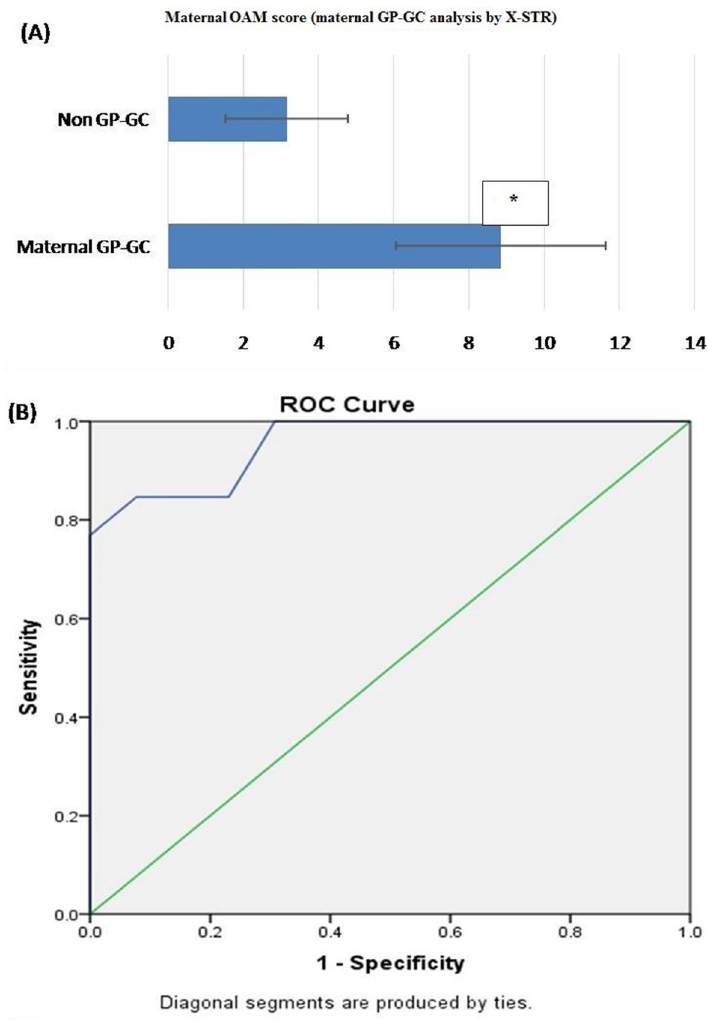
Figure 9. ( A ) OAM score for maternal GP-GC analysis by X-STR: Based on OAM score, statistically significant difference between maternal GP-GC (related) and non-GP-GC (unrelated) groups was seen with X-STR. The average OAM score for GP-GC is 8.85 ± 2.794 (SD), whereas, for the non-GP-GC group, the average OAM is 3.15 ± 1.625 (SD). Figure 9 ( A,B ) obtained from SPSS software version 22.0 (Available for download at: https:// www. ibm. com/ suppo rt/ pages/ downl oading- ibm- spss- stati stics- 22). *Statistically significant difference (p < 0.05). ( B ) ROC curve (AUC 95.6% ) , showing the performance of OAM score as a screening test for maternal GP-GC pairs by